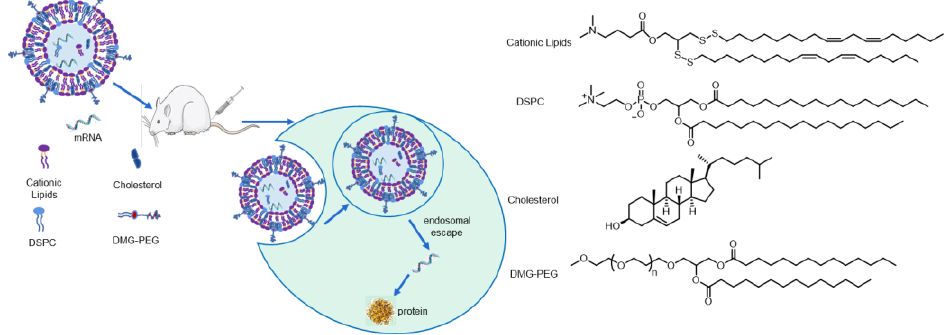
Figure 1. Schematic illustration of LNPs with disulfide bond-containing cationic lipids for mRNA